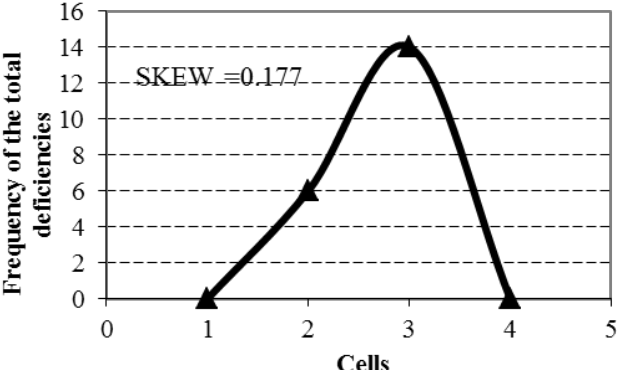
Fig. 6. Frequency distribution of the total deficiencies observed.